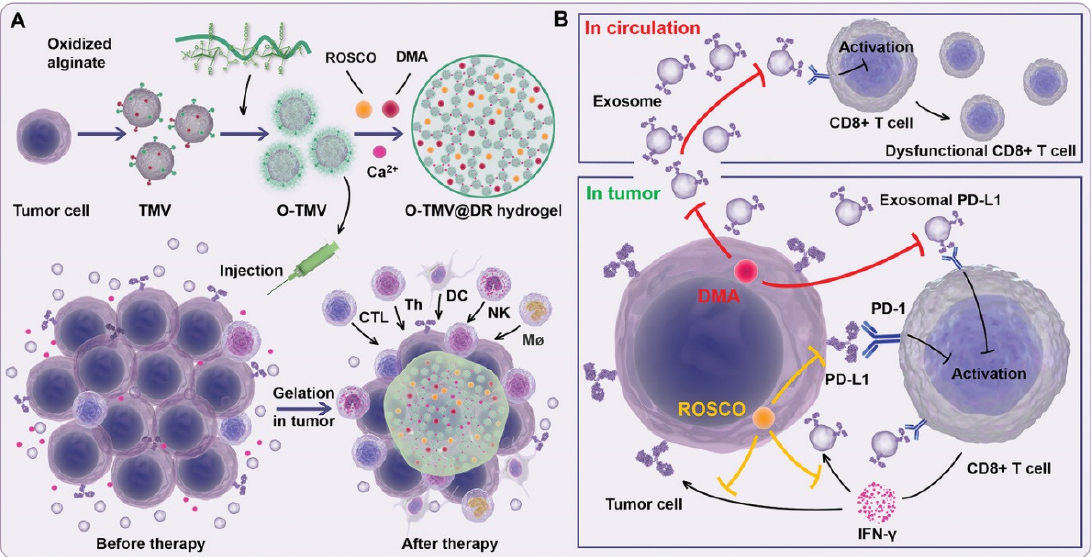
Figure 6. Schematic diagram of TCMVs-based injectable hydrogels for ICT. ( A ) Oxidized sodium alginate is adsorbed on the surface of TCMVs to form a gel, and after injection into the tumor, Ca 2+ in the microenvironment would chelate with the particles to form a gel, causing an antigen reservoir effect and continuous recruitment to activate antigen-presenting cells and lymphocytes. ( B ) Adding DMA and ROSCO to the gel blocks Ca 2+ entry into tumor cells and inhibits the secretion of circulating PD-L1 and tumor PD-L1 exosomes. Reproduced with permission [74]. Copyright 2021, Wiley-